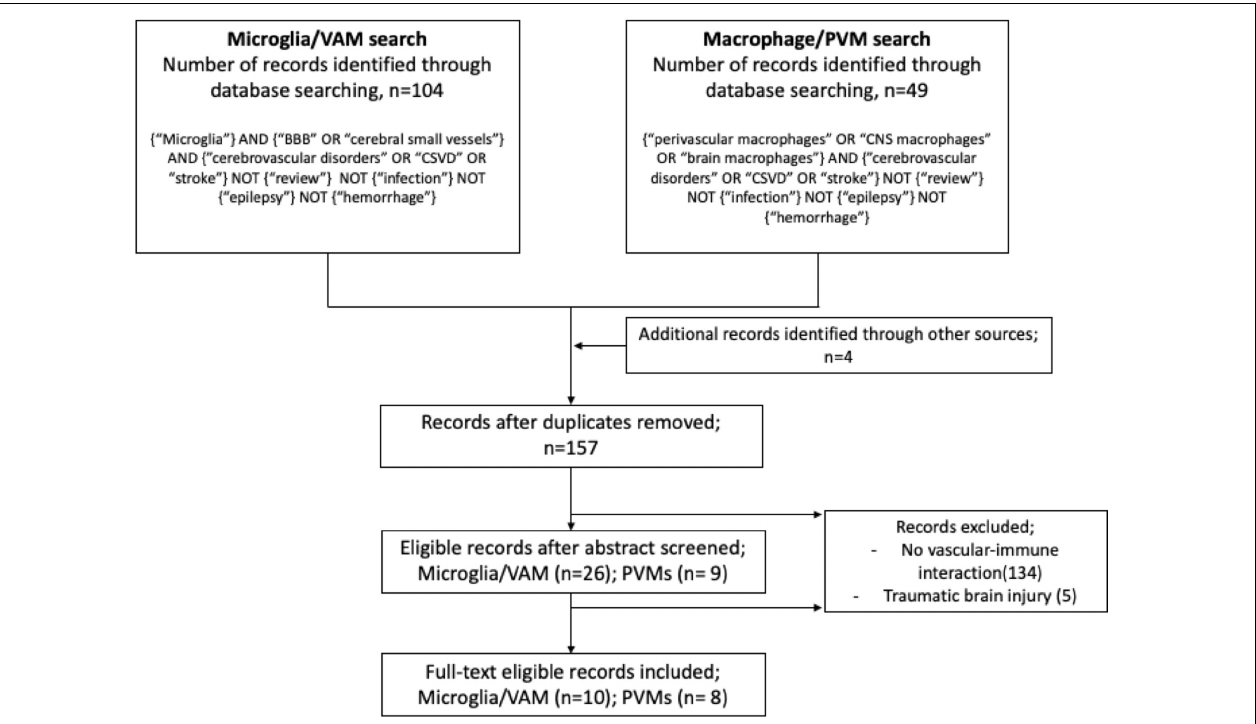
FIGURE 2 | Flow diagram illustrating the systematic search protocol and the identification of the corresponding publication